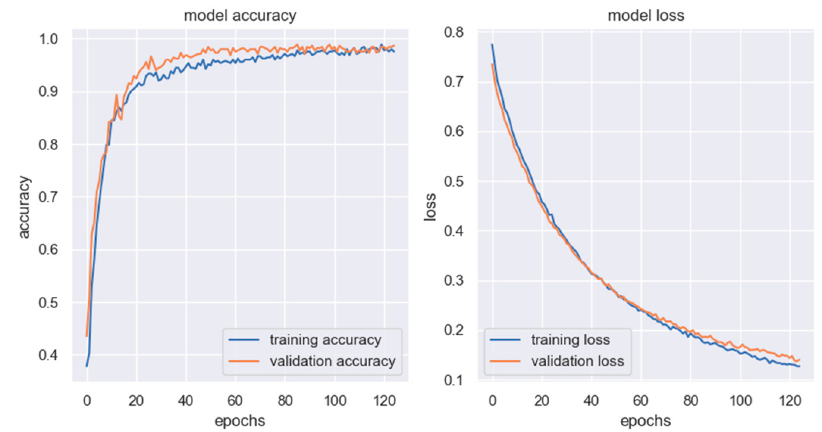
Figure 13. Training history of MobileNetV2 architecture.